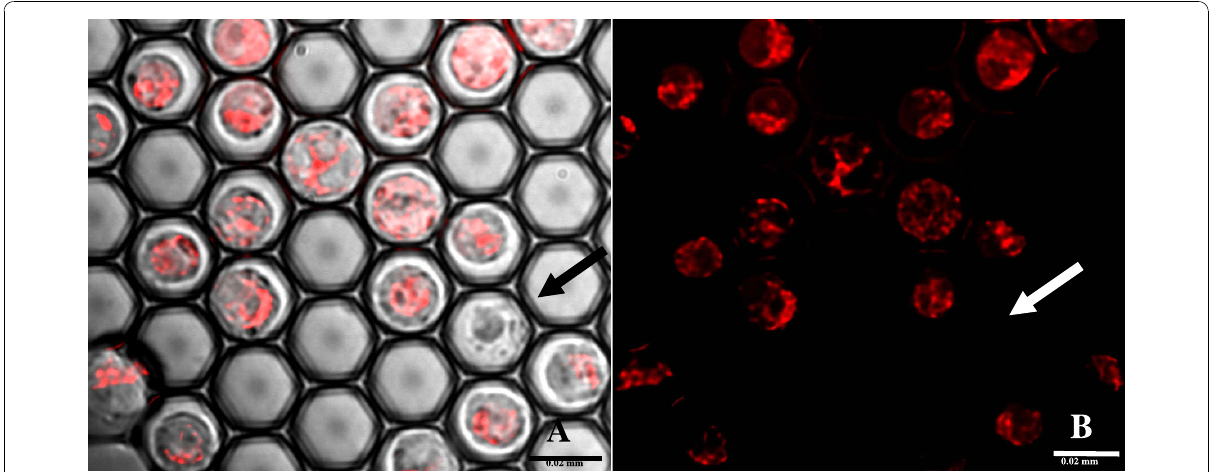
Figure 3 Mitochondrial staining of untreated U937 cells by TMRM (200 nM), a potentiometric membrane dye which accumulates in the mitochondria . Images (× 60 magnification): the overlay of transmitted light and fluorescent images (A) and the corresponding fluorescent image (B) are presented. The white arrow indicates a TMRM negative U937 cell, also characterized by its morphological appearance in the transmitted light image. Scale bar: 0.02